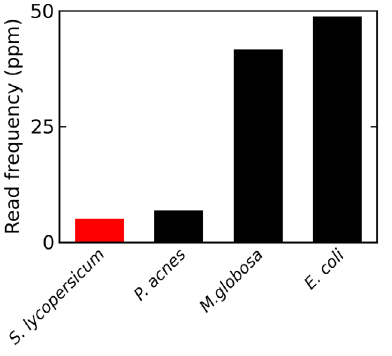
Figure 5. Reads matching the tomato chloroplast genome are less frequent than other contaminant matching reads in samples of cell-free DNA. Spisak et al [28] used the frequency of reads matching chloroplast genomes as evidence that genes pass intact from food to the bloodstream, and found S. lycopersicum (tomato) to be the most common contaminant. Evenly sampling from all of the sequencing samples generated by Spisak et al, I used identical criteria to investigate potential matches to three other contaminant species, E. coli, P. acnes and M. globosa. P. acnes and M. globosa are associated with the human skin flora. The frequency of reads matching each of these contaminant reads, per million reads in the pooled samples, is depicted.